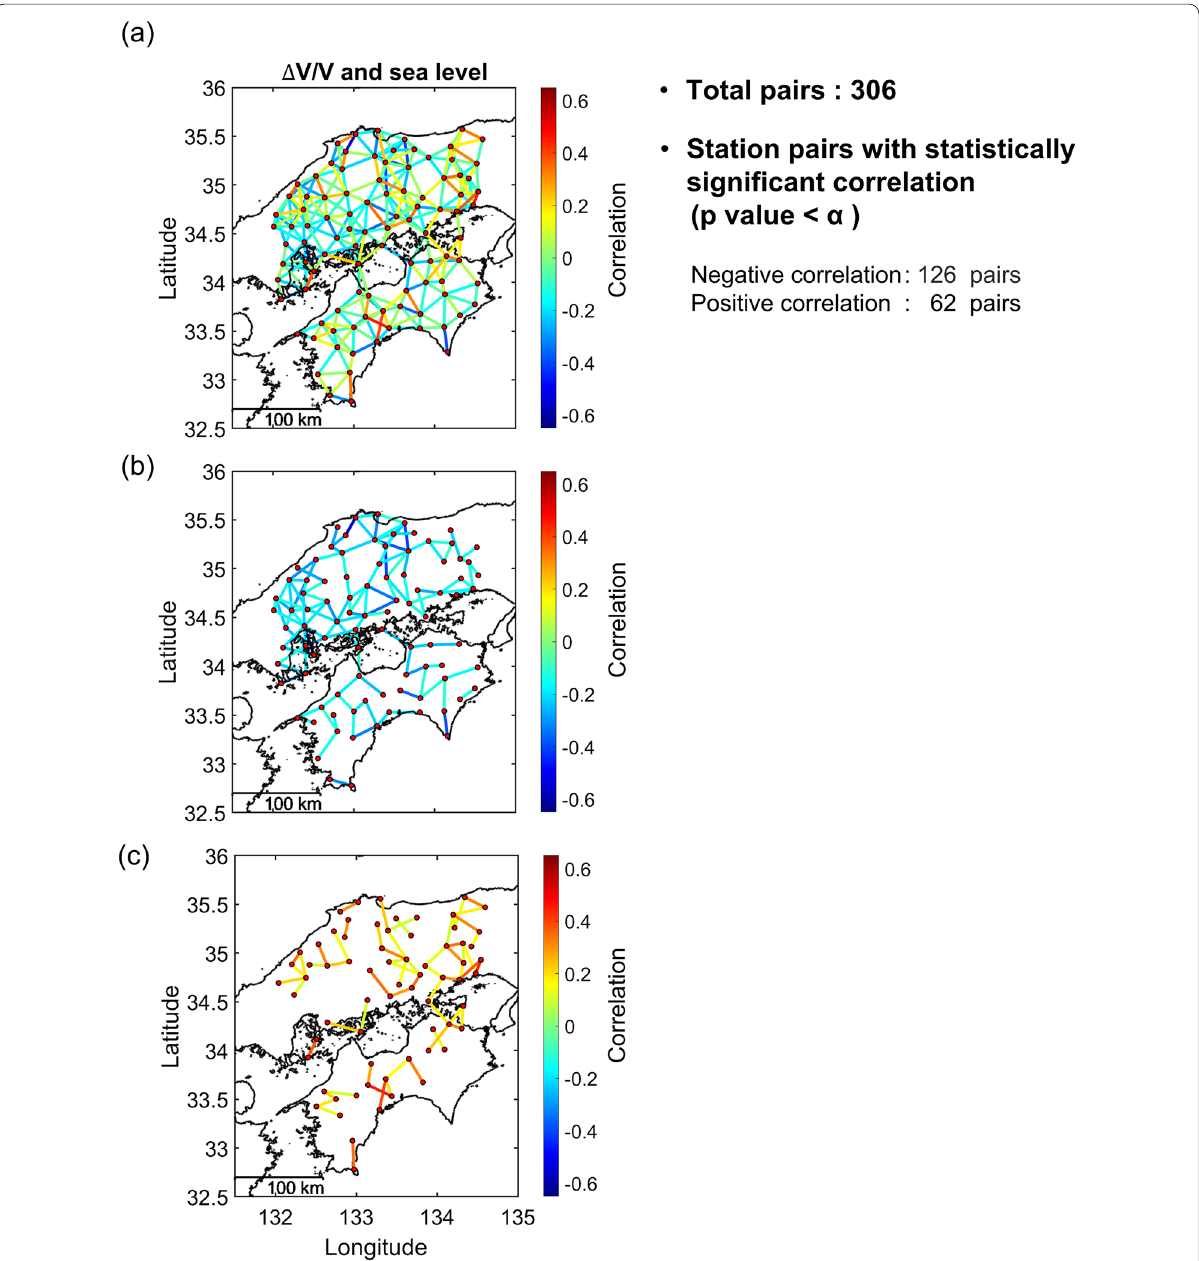
Fig. 9 Maps of the study region showing correlations between seismic velocity change and sea level for a all seismic station pairs, b station pairs with statistically significant negative correlations, and c station pairs with statistically significant positive correlations. Seismic velocity changes and sea level data are filtered within the 64- to 274-day period